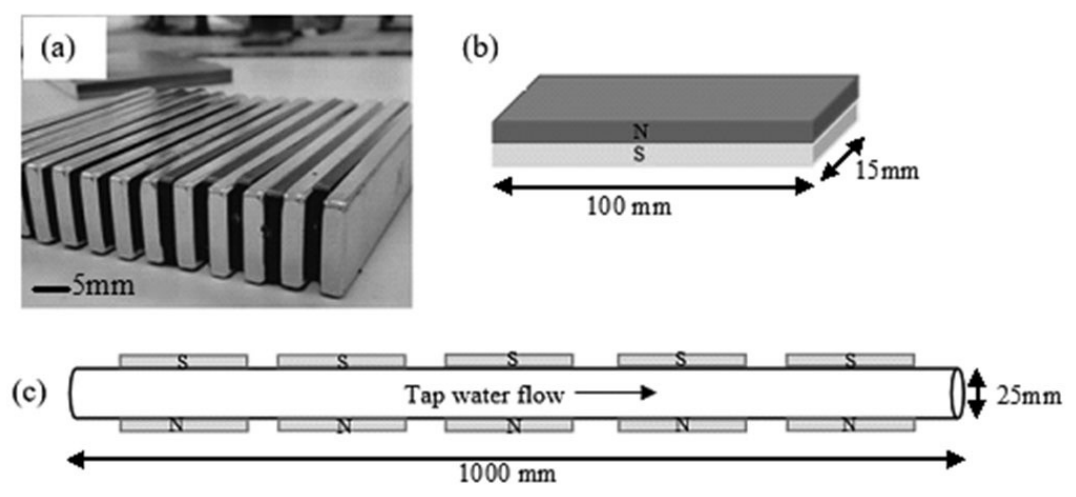
Figure 1. (a) Rectangular NdFeB permanent magnets used in this study, (b) faces of each magnet acting as the poles, and, (c) magnets assembled with a pipe. Table 1. Chemical composition of S45C Steel